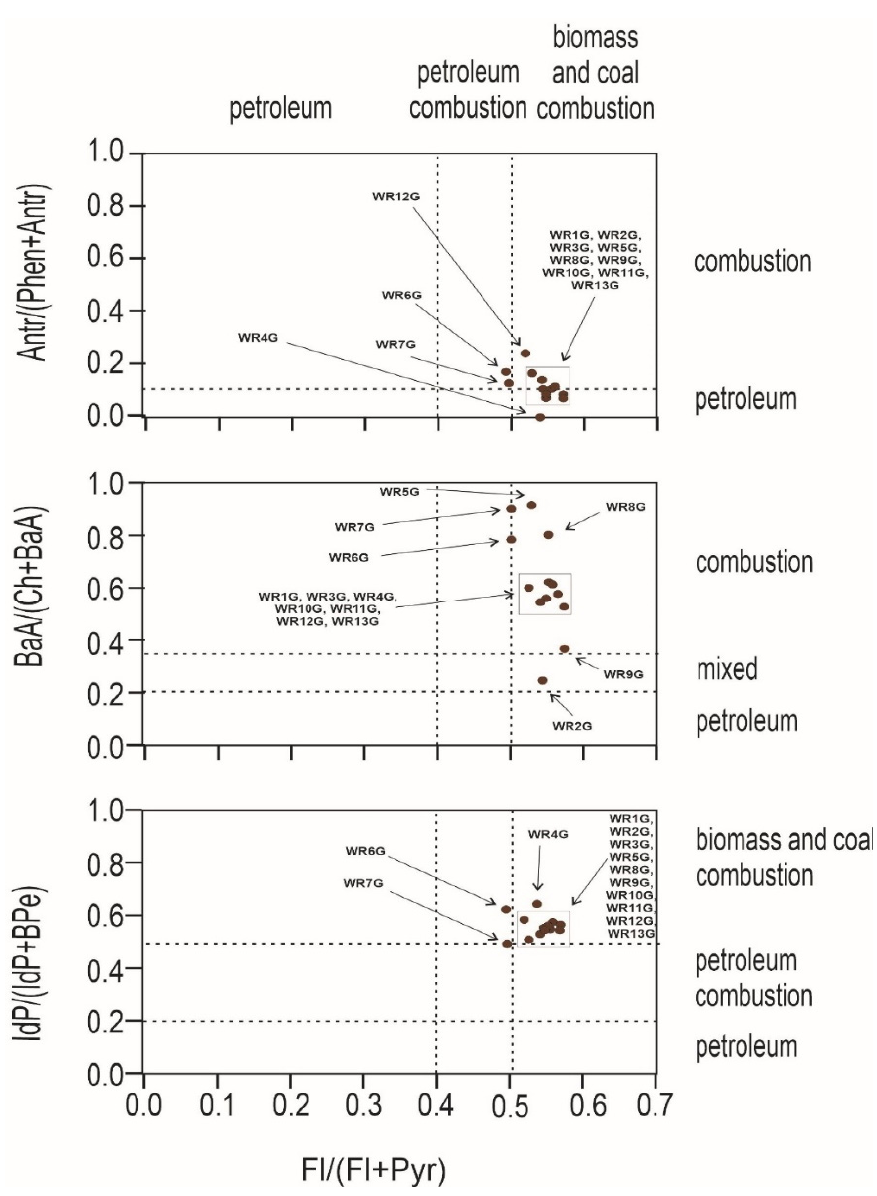
Figure 4. Diagnostics diagrams of PAHs in soils investigated from wild waste dump in Trzebinia on Słowackiego Street. A—anthracene, P—phenanthrene, Fl—fluoranthene, Py—pyrene, BaA— benzo(a)anthracene, Ch—chrysene, IP—indeno(1,2,3-cd)pyrene, BghiP—benzo(ghi)perylene.